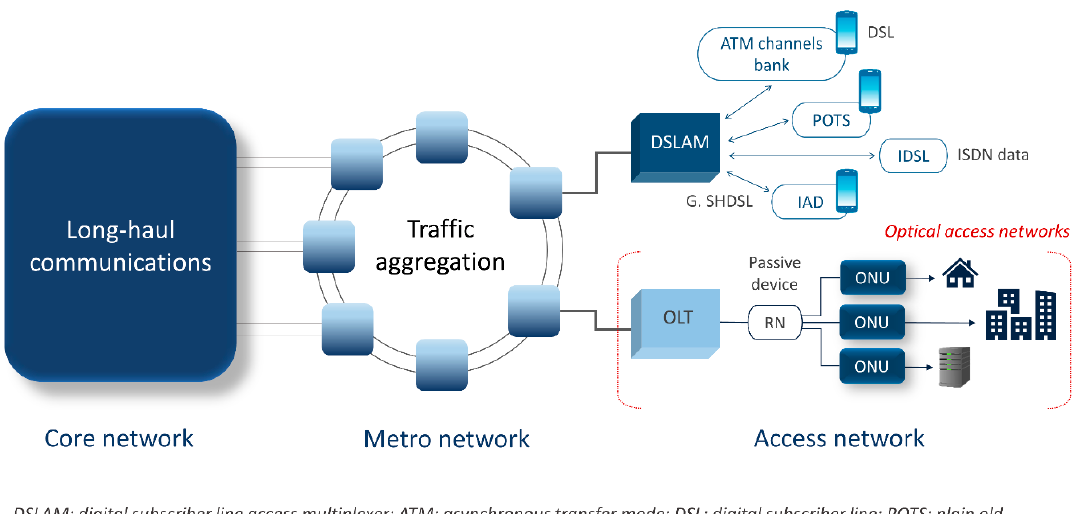
Figure 1. Diagram of a telecommunications network infrastructure, based in [3].